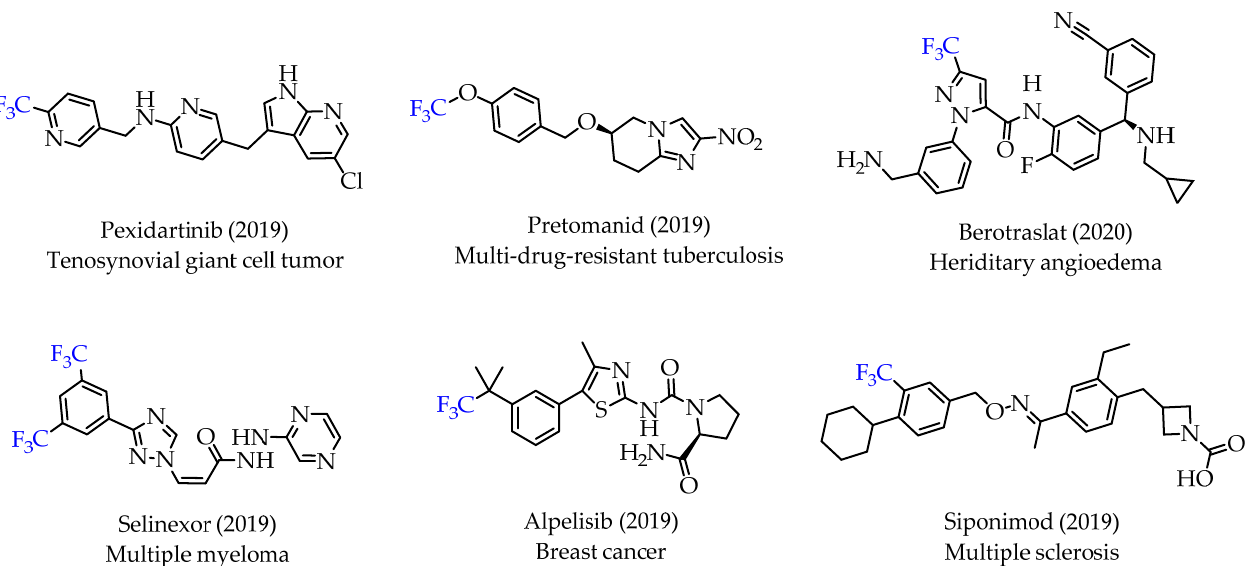
Figure 1. Representative examples of recently approved drugs with trifluoromethyl groups.